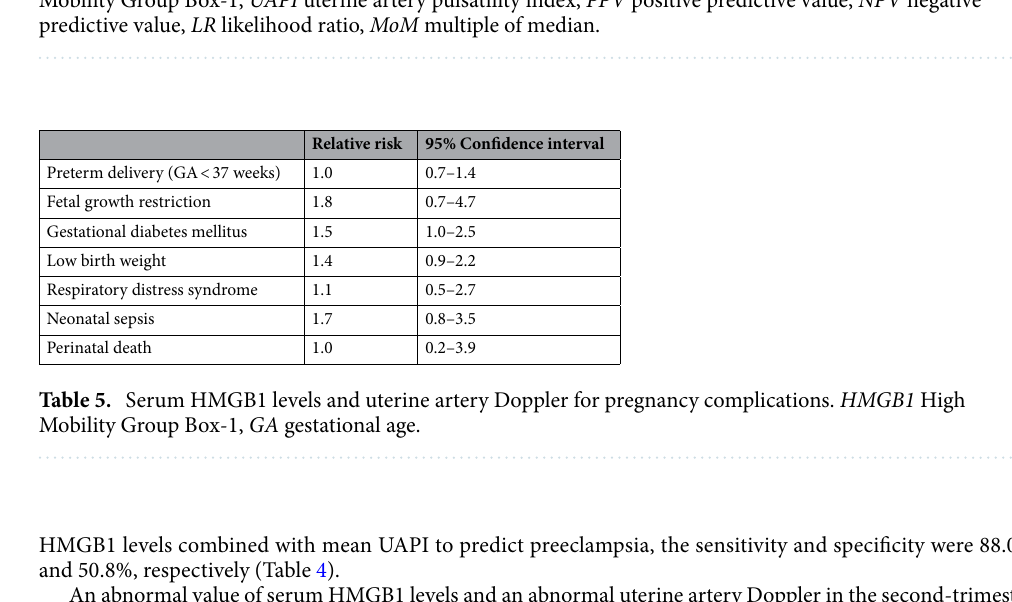
Table 4. Predictive value of serum HMGB1 levels and uterine artery Doppler for preeclampsia. HMGB1 High Mobility Group Box-1, UAPI uterine artery pulsatility index, PPV positive predictive value, NPV negative predictive value, LR likelihood ratio, MoM multiple of median.